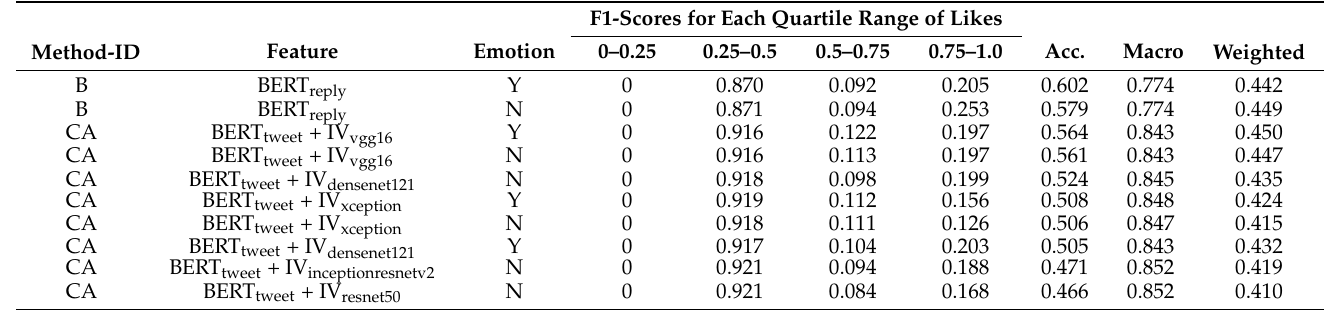
Table 4. Top 10 F1-scores and accuracies of like prediction (proposed methods). F1-Scores for Each Quartile Range of Likes